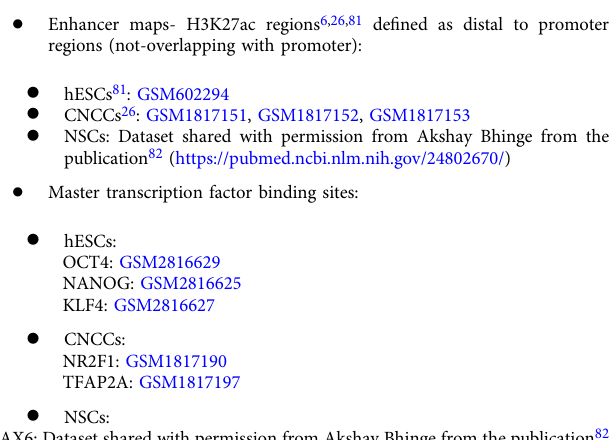
version: 3.6.1 (2019-07-05)). The differential gene expression analysis between each pair of cells (hESCs versus CNCCs, hESCs versus NSCs and NSCs versus CNCCs) was performed with EdgeR 81 using the expected_counts from the gene.results fi les generated during the alignment step. For each pairwise comparison, genes with differential expression (FDR< 0.05 and abs(log2FC)>1) were called using the function glmQLFit taking into account the presence of multiple biological replicates in the experimental design matrix (5 for hESCs, 3 for CNCCs and 4 for NSCs). For each cell type expression levels have been summarised as the median TPM observed across all the biological replicates. The differential gene expression analysis for samples in the PhenDC3 experiment was performed as above with differential expression cutoff FDR <0.05 and abs(log2FC)>2. External histone modi fi cations ChIP-seq processing . Histone modi fi cation ChIP-seq maps were downloaded from the Sequence Read Archive database (SRA) using fastq-dump (version: 2.10). Adaptor trimming and alignment was performed similarly to the G4-ChIP-seq. The list of data used by cell type is the following. hESCs: